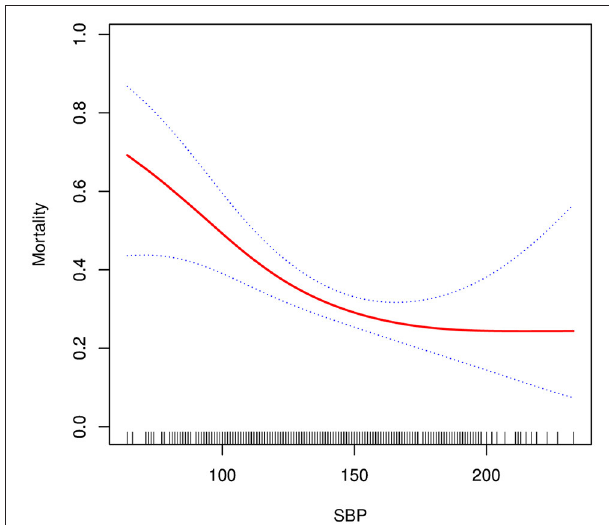
FIGURE 2 | Association between systolic blood pressure and in-hospital mortality. A non-linear association between systolic blood pressure and in-hospital mortality was found ( P = 0.009) in a generalized additive model (GAM). The solid red line represents the smooth curve fit between variables. Blue bands represent the 95% confidence interval from the fit. All adjusted for age, gender, BMI, smoking, hypertension, diabetes, Marfan syndrome, Bicuspid aortic valve, CRI, stroke, atherosclerosis, time to presentation, aortic diameter, aortic regurgitation, abdominal vessel involvement, arch vessel involvement, EF value, symptom, Cr, TG, TC, HDL, LDL, and management.